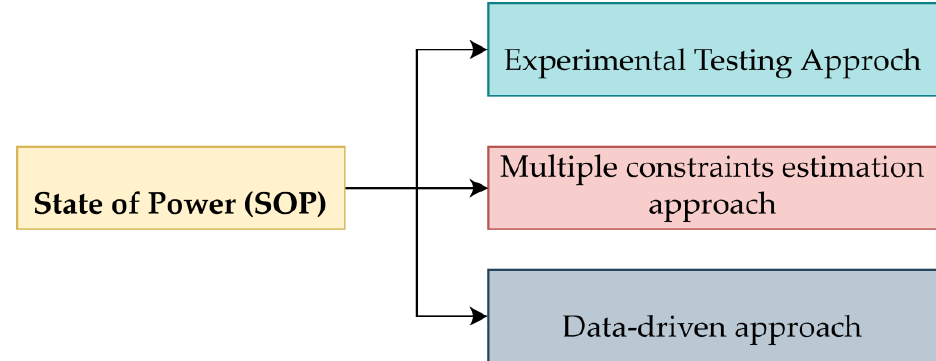
Figure 18. SOP estimation approaches.